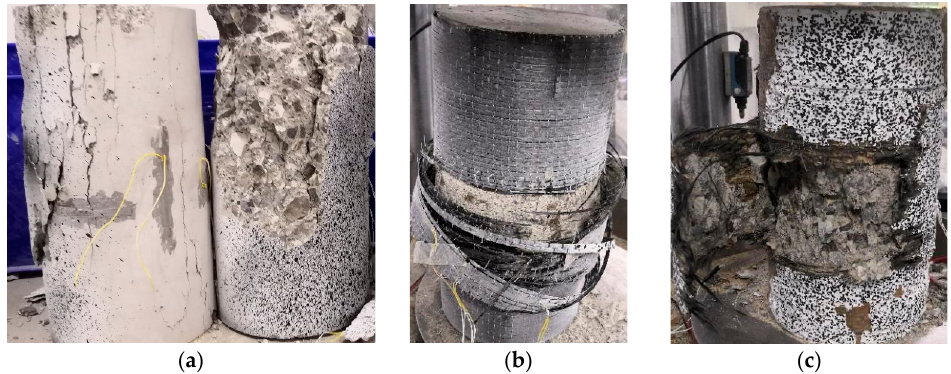
Figure 3. The typical failure modes of the ( a ) unconfined, ( b ) two ‐ layer FRP ‐ confined, and ( c ) three ‐ layer FRiP ‐ confined specimens.